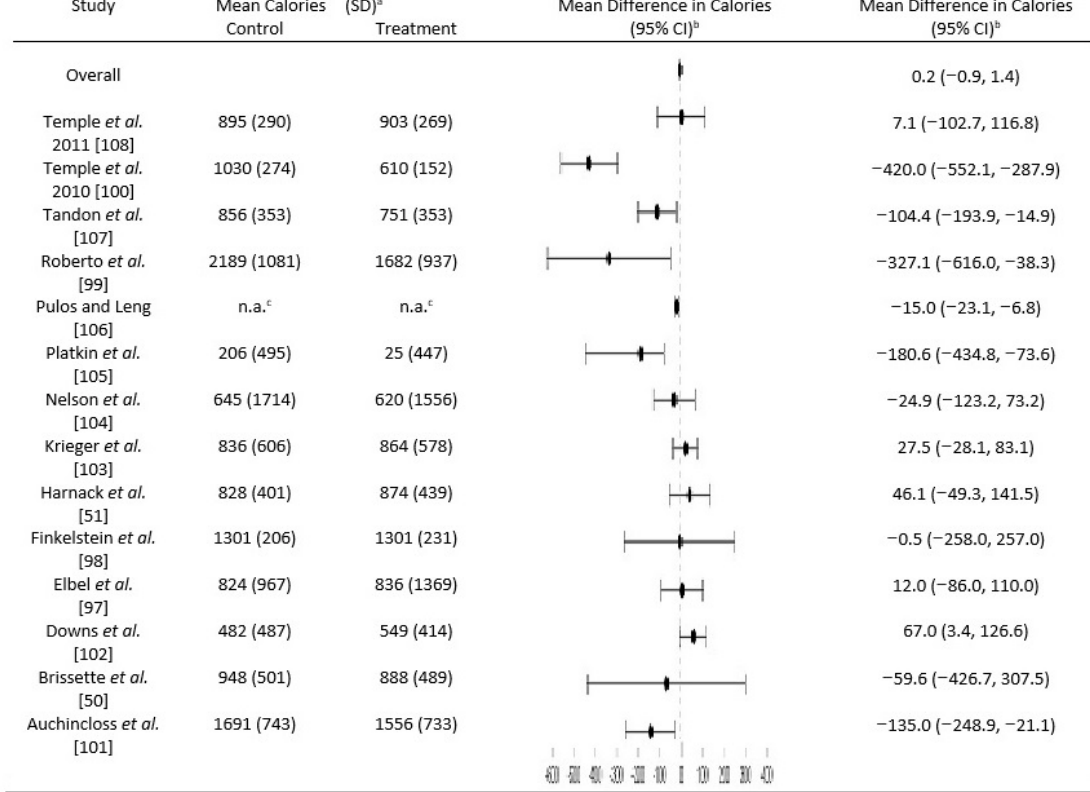
Figure 2. Forest plot showing the overall and study-specific mean differences with 95% CI. For each condition or subgroup, the full dot represents the point estimate of the menu label effect. The horizontal lines join the lower and upper limits of the 95% CI of these effects. Before-intervention mean calories are shown in the control mean calories column for before and after study designs used by Krieger et al. [103], Pulos and Leng [106], and Downs et al. [102]. a SD, Standard Deviation; b CI, Confidence Interval; c n.a.: Data not available.